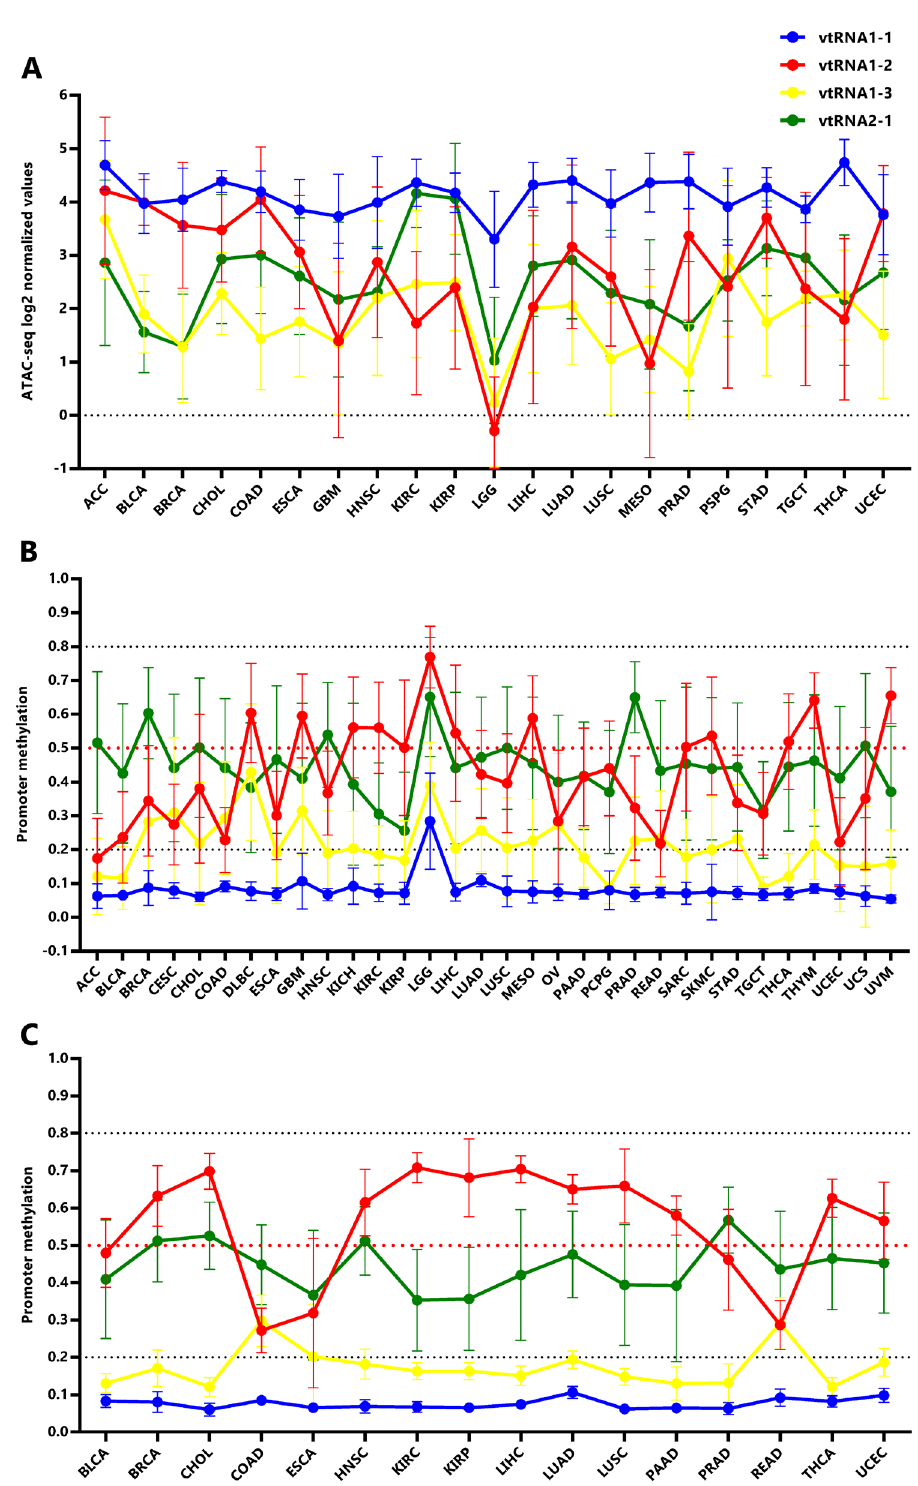
Figure 4. Chromatin accessibility and DNA methylation of the vtRNA promoters in tumor and normal tissues. A. ATAC-seq values for vtRNA promoters in 21 primary tumor tissues. B. Average beta-values of promoter DNA methylation for vtRNAs in 32 primary tumors tissues. C. Average beta-values of promoter DNA methylation for vtRNAs in 16 normal adjacent tissues. The charts show the average value and standard deviation of each vtRNAs for the tissues with at least five samples available at Pan-Cancer TCGA